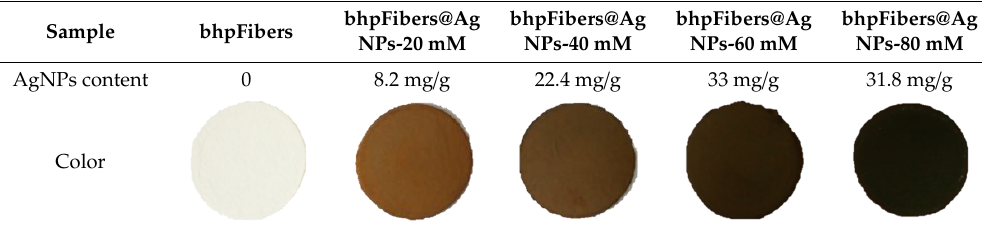
Figure 5. The SEM images (a–d) of bhpFibers@AgNP-based paper prepared by 0.2 mg / mL DLA and Table 1. The color and the AgNPs content on the Table 1. The color and the AgNPs content on the samples. Table 1. The color and the AgNPs content on the samples. Table 1. The color and the AgNPs content on the samples. Table 1. The color and the AgNPs content on the samples. Figure 5. The SEM images (a – d) of bhpFibers@AgNP-based paper prepared by 0.2 mg/mL DLA and di ff erent concentrations of AgNO 3 : ( a ) 20 mM, ( b ) 40 mM, ( c ) 60 mM, ( d ) 80 mM. different concentrations of AgNO 3 : ( a ) 20 mM, ( b ) 40 mM, ( c ) 60 mM, ( d ) 80 mM. Table 1. The color and the AgNPs content on the samples. Table 1. The color and the AgNPs content on the samples.